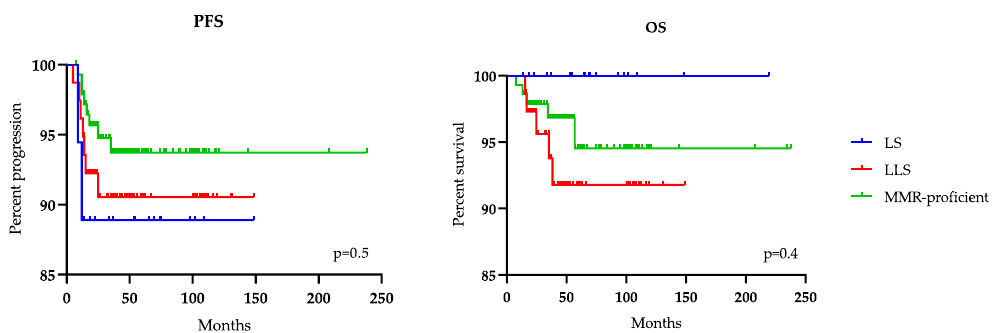
Figure 4. Kaplan-Meier curves for Progression Free Survival (PFS) and Overall Survival (OS) of Lynch Syndrome (LS), Lynch-like Syndrome (LLS) and MMR-proficient groups.